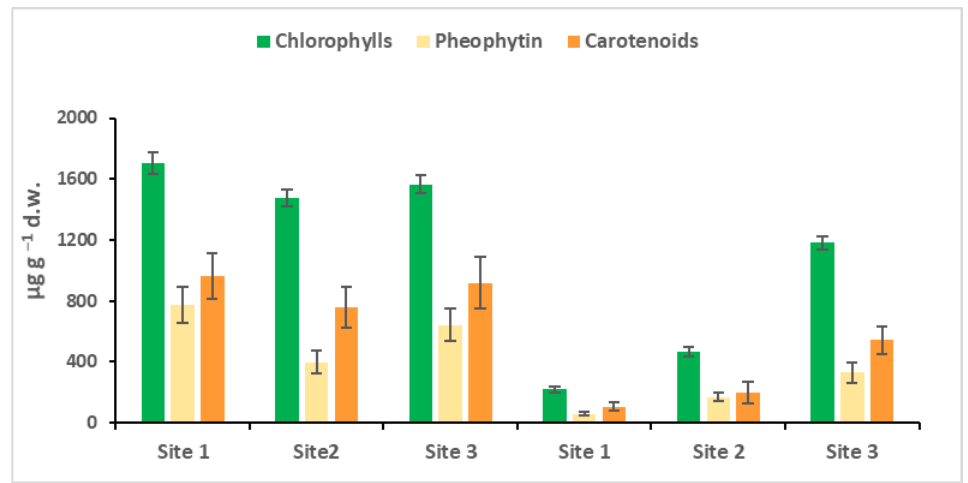
Figure 3. Chlorophyll, pheophytin, and carotenoid quantification in each biofilm sample in March and October. Site 1 (Villadossola), Site 2 (Bosco Tenso), Site 3 (Ornavasso). Dry weight = d.w.